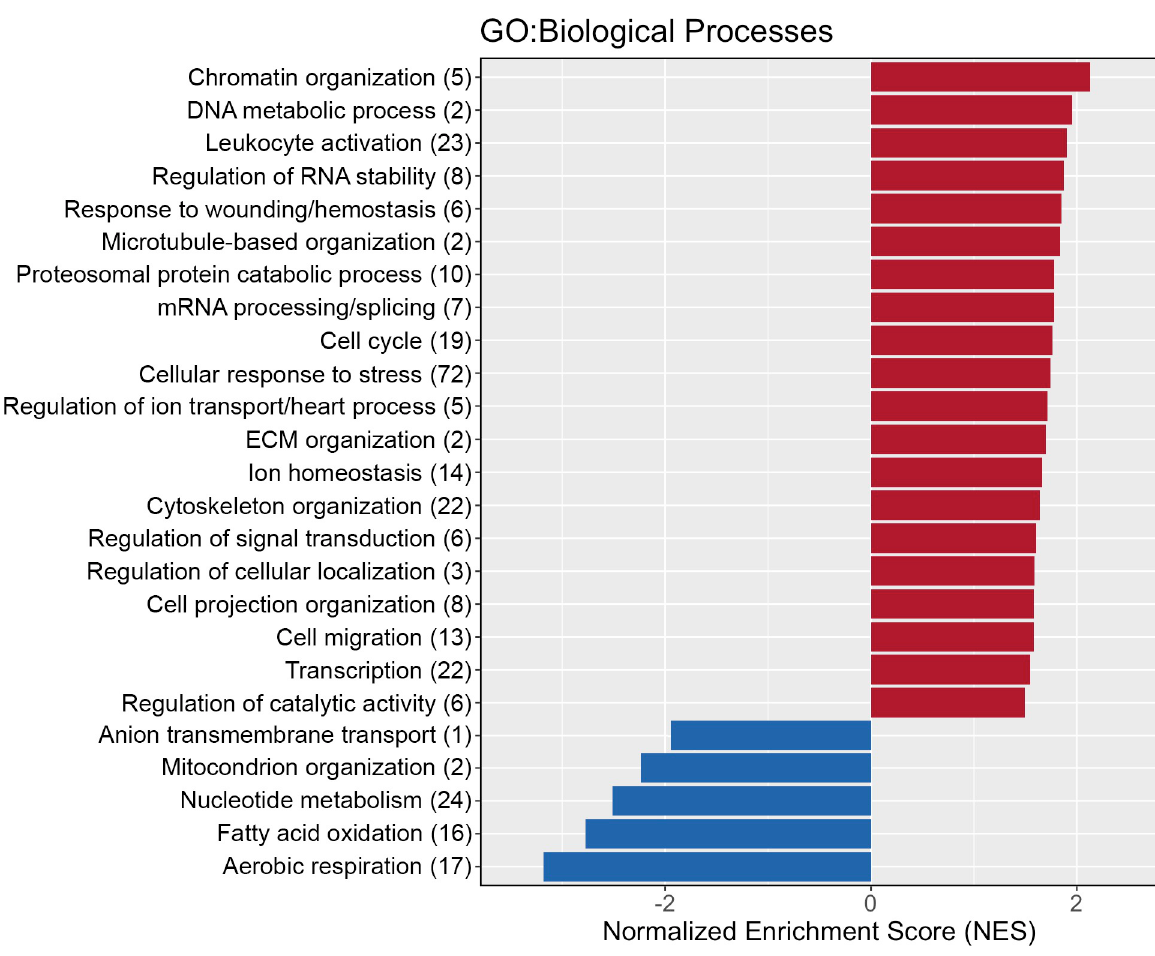
Fig 5. Characterisation of the 24 clusters of Gene Ontology Biological Processes (GOBP) formed. Title of bars are representative terms for each cluster, and the number of GOBPs within each cluster are represented in parenthesis. Colour represents direction of change in expression of the majority of GOBPs within that cluster compared to baseline (red = positive enrichment, blue = negative enrichment). The magnitude of bars represents the largest normalised enrichment score of a GOBP within that cluster.